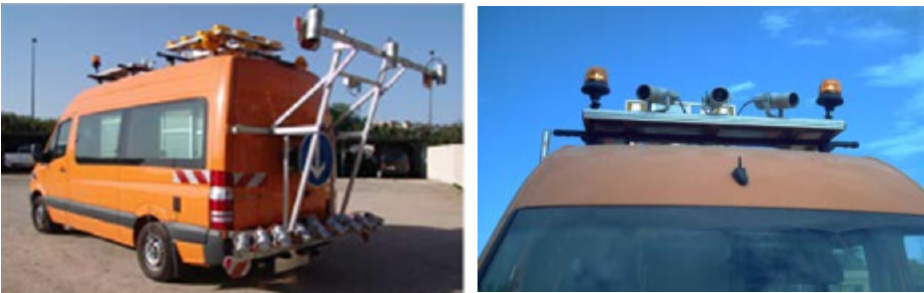
Figure 1. Multifunctional Pavement Inspection System SMAC with macro cameras ( left ) and front cameras ( right ).